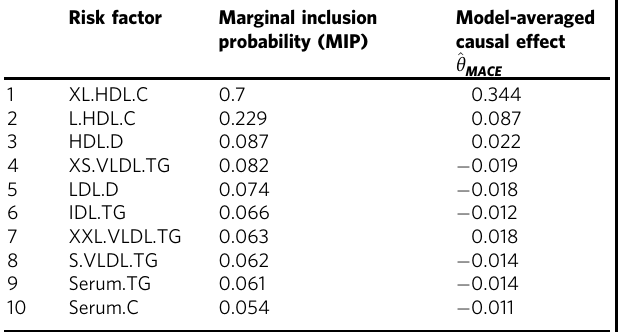
Results are given after excluding genetic variants in the APOE , FUTC , and LIPC regions. ^ θ MACE is the model-averaged causal effect of a risk